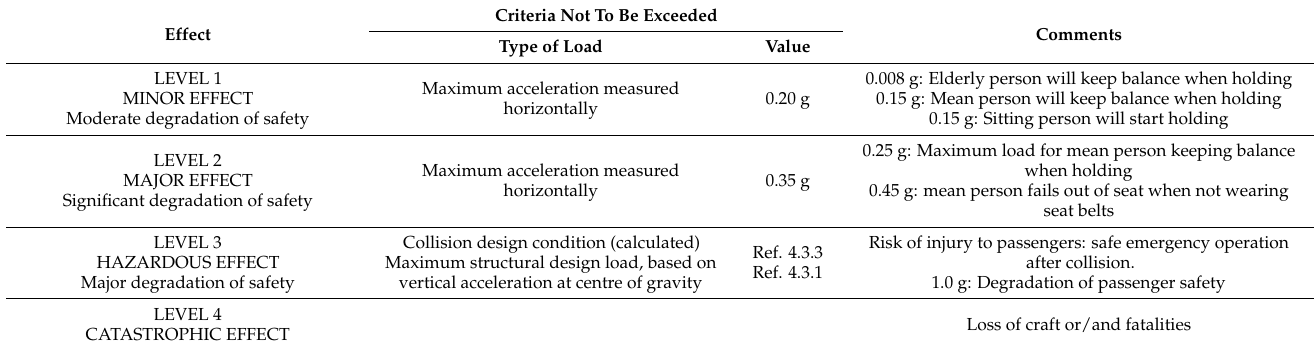
Table 14. Maximum acceleration criteria as per International Code of Safety for High-Speed Craft.